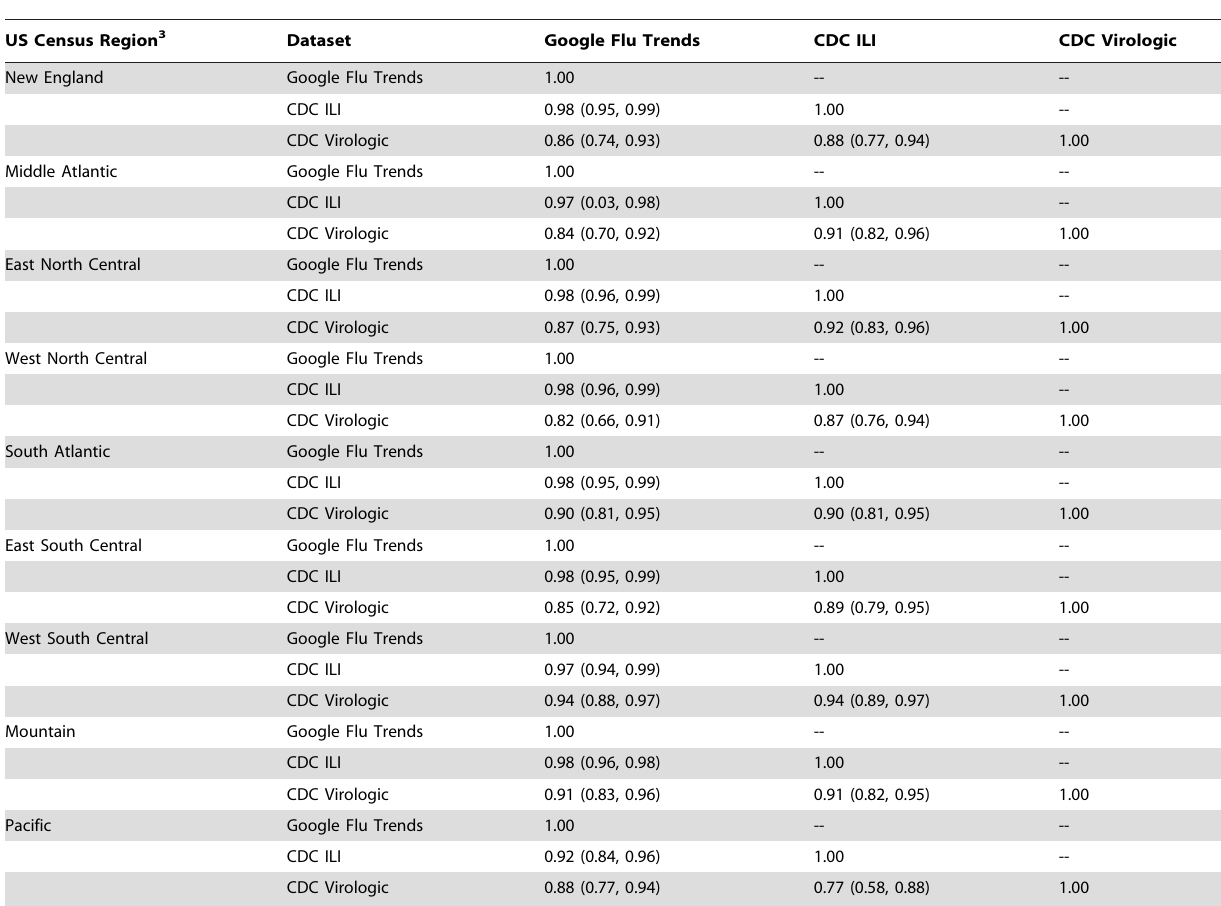
Table 4. Pearson’s Correlation Coefficient Matrix of Three Influenza Surveillance Systems by US Census Region during the